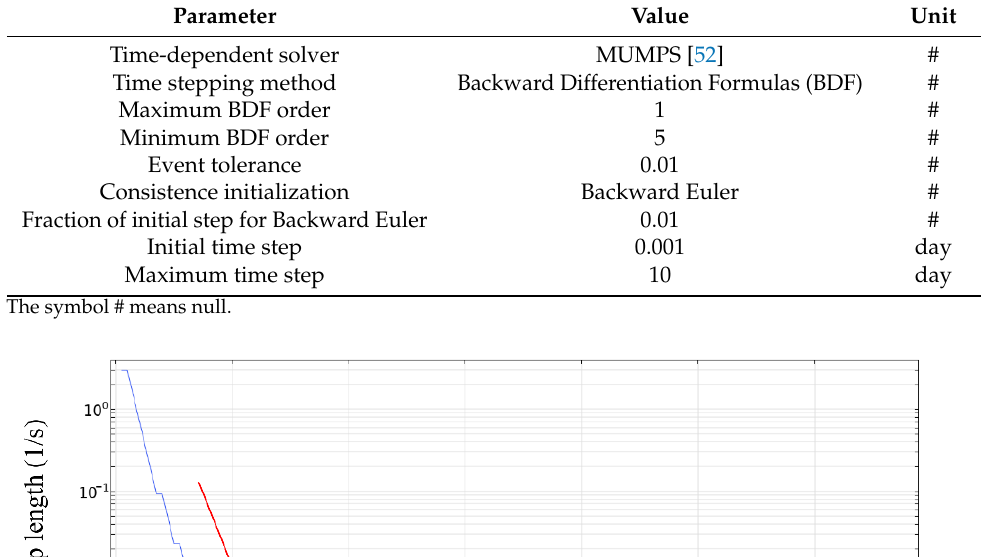
Table 3. Parameters for the numerical setting.